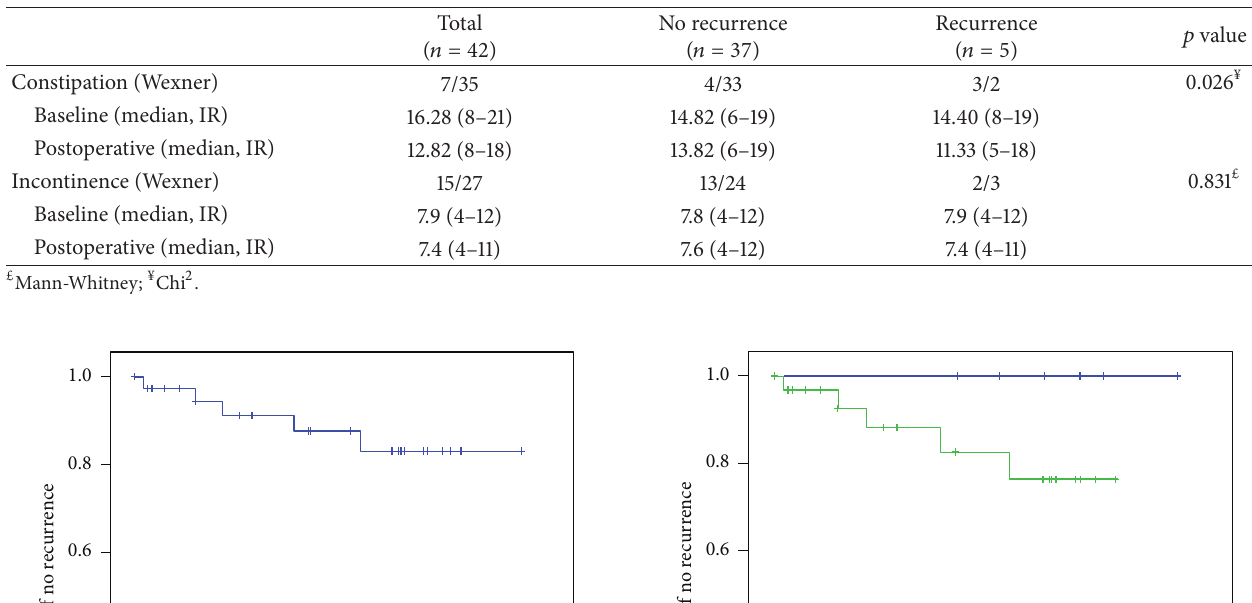
Table 3: Functional outcomes of Delorme’s procedure.